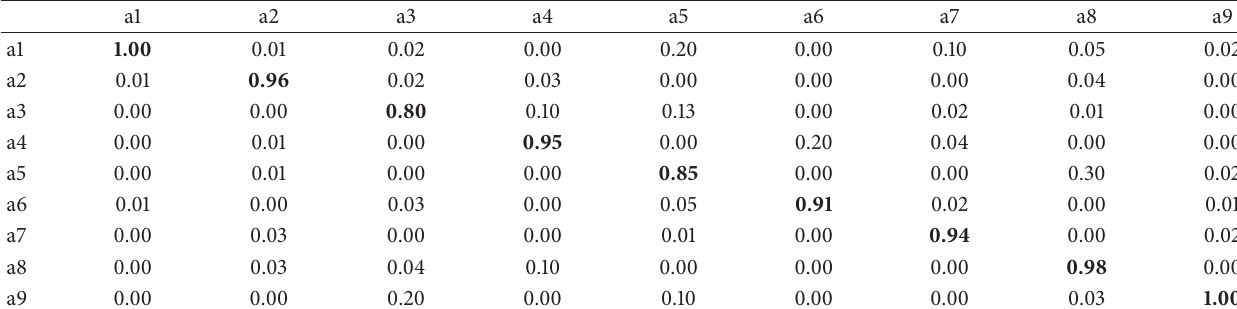
Table 2: Confusion matrix for the Weizmann dataset.